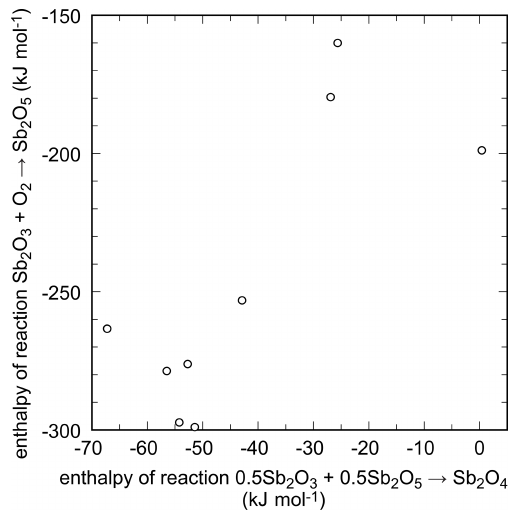
Figure 5. Enthalpies of reactions that relate the antimony oxides with different oxidation state of antimony. The data are summarized in Table